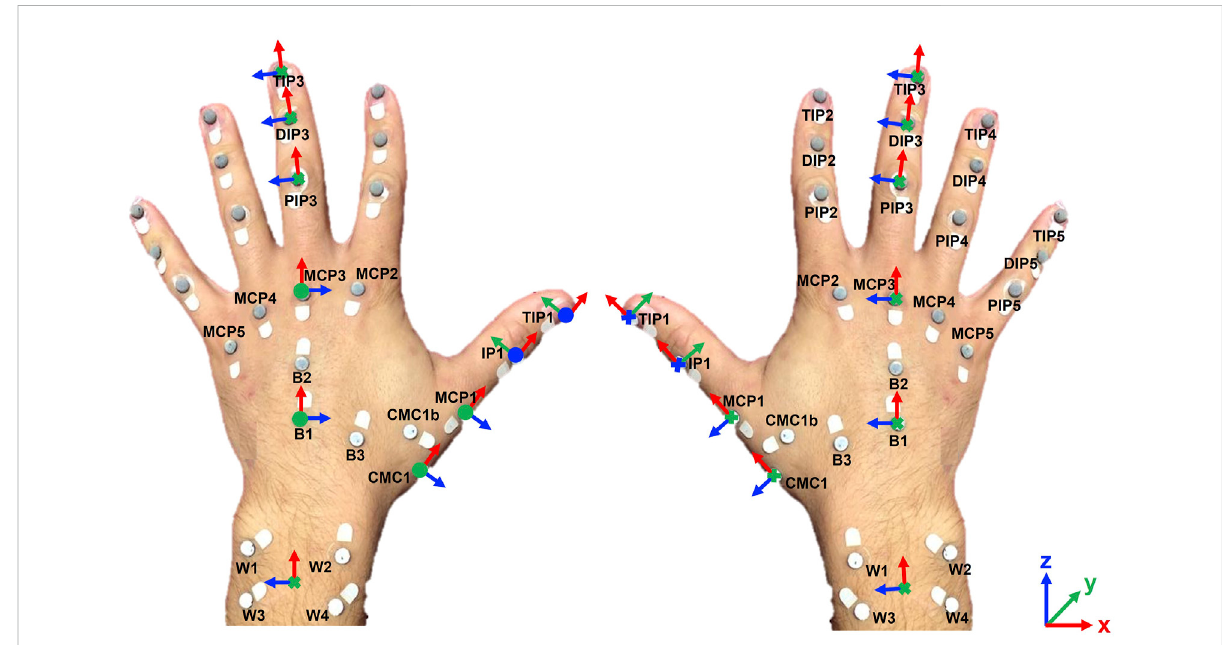
FIGURE 2 Markers placement on speci fi c anatomical landmarks and local joint reference frames de fi nition for the right and left hand.